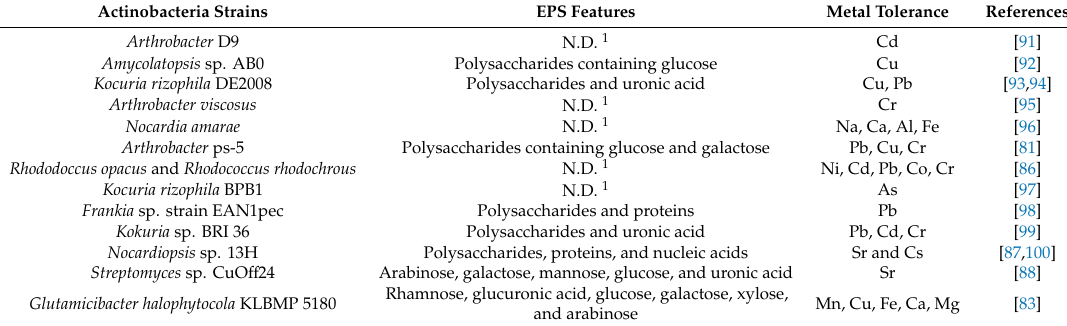
Table 2. Extracellular polymeric substances (EPS) produced by Actinobacteria as biosorbents for